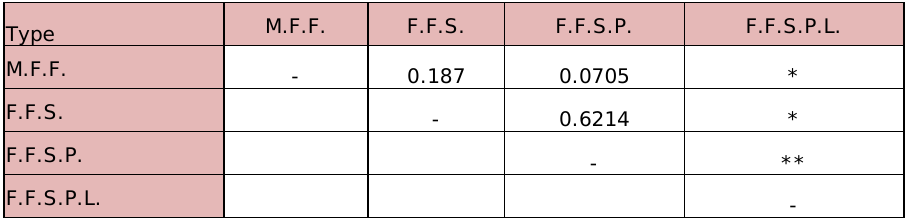
Table 4. Fisher’s LSD on Number of Fixations Points. Source: Own